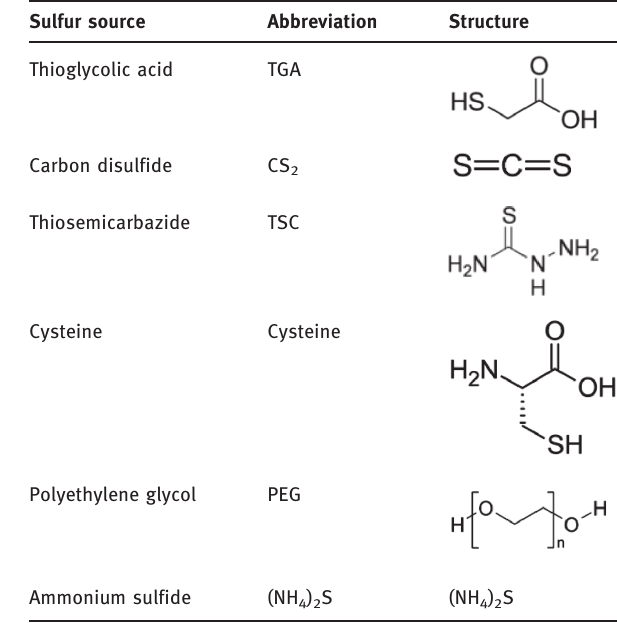
Table 2: The sulfur sources